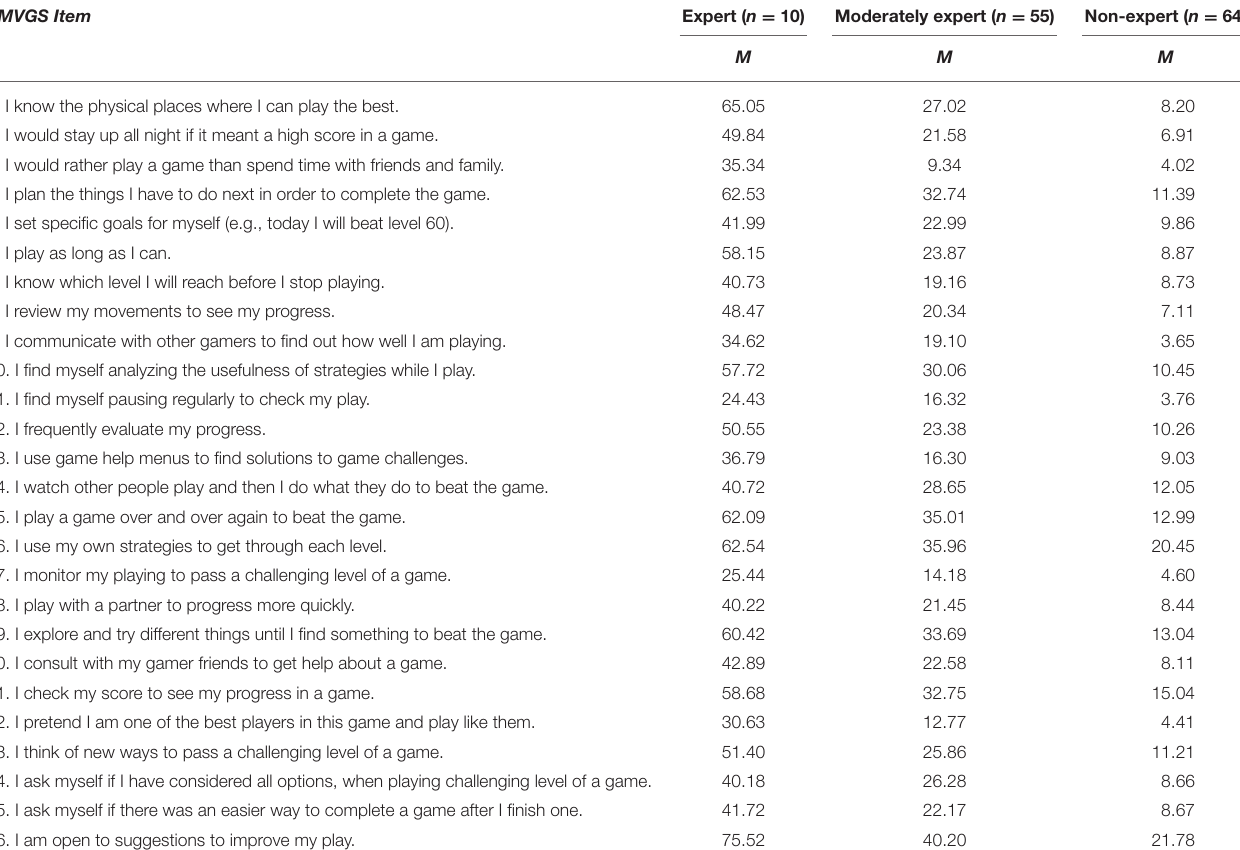
TABLE 6 | Mean scores of three expertise groups for each item of the PMVGS *